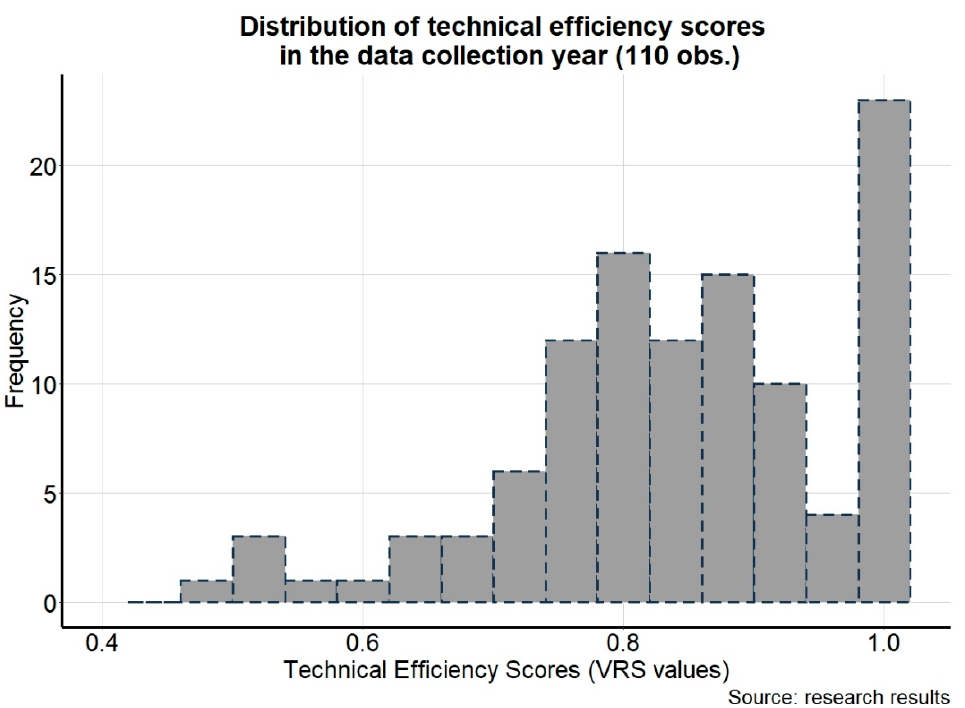
Figure 2. Distribution of technical efficiency scores in the data collection year (110 observations).